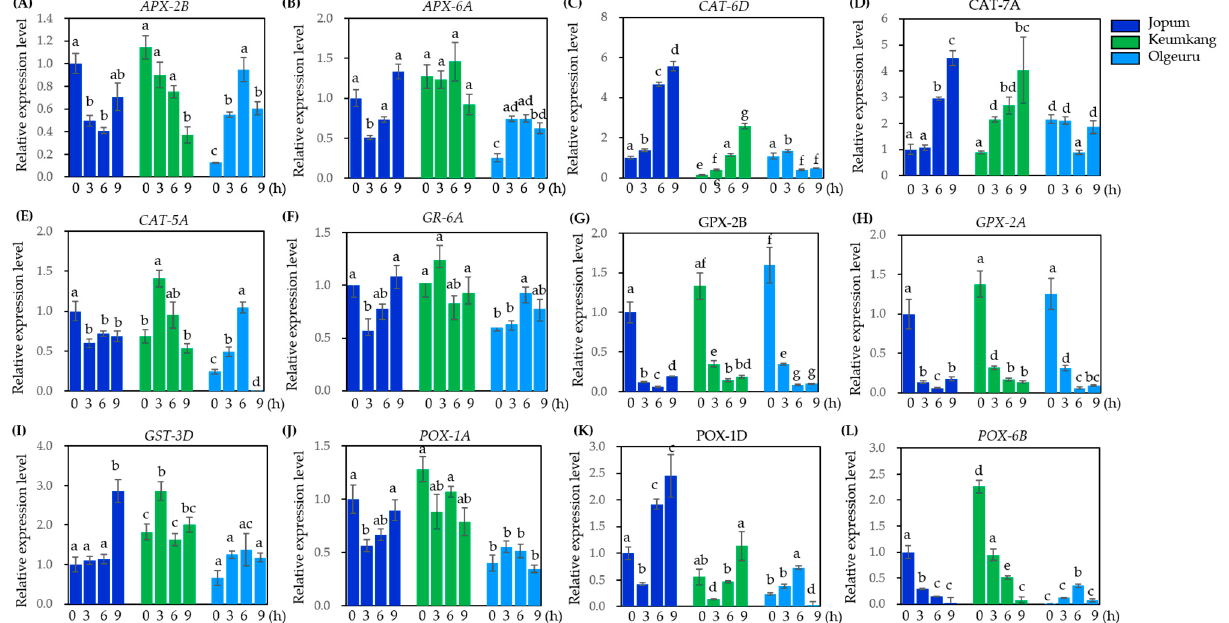
Figure 7. Relative expression level of selected ROS-scavenging genes by RNA-seq analysis. Relative gene expression level of APXs , TraesCS2B02G457600.1 ( A ), and TraesCS6A02G412900.1 ( B ); CATs TraesCS6D02G0483600 ( C ); TraesCS7A02G549800 ( D ); and TraesCS5A02G49800.1 ( E ); GR , TraesCS6A02G383800.2 ( F ); GPXs TraesCS5A02G604800 ( G ); and TraesCS2A02G582100.1 ( H ); GST TraesCS3D02G299900.1 ( I ); POXs TraesCS1A02G77700.2 ( J ); TraesCS1D02G096400.1 ( K ); and TraesCS6B02G303900.1 ( L ). Wheat leaves were heat-treated at 35 °C during 3, 6, and 9 h. Data are representative results from three independent experiments. Error bars represent SD ( n = 3). Different letters on the bars indicate significant differences between treatments (ANOVA followed by Tukey’s test, p < 0.05). APX, ascorbate peroxidase; CAT, catalase; GPX, glutathione peroxidase; GST, gluta- thione S-transferase; GR, glutathione reductase.